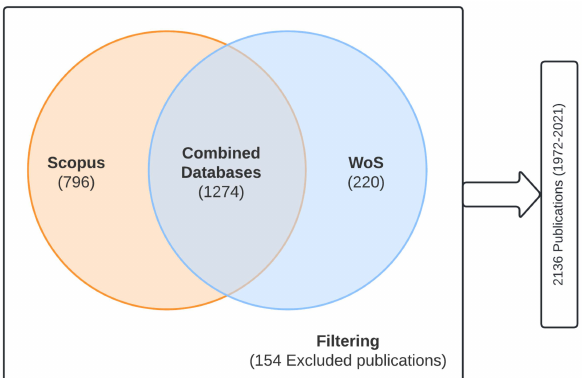
Figure 2. Distribution of publishing sources about floods.